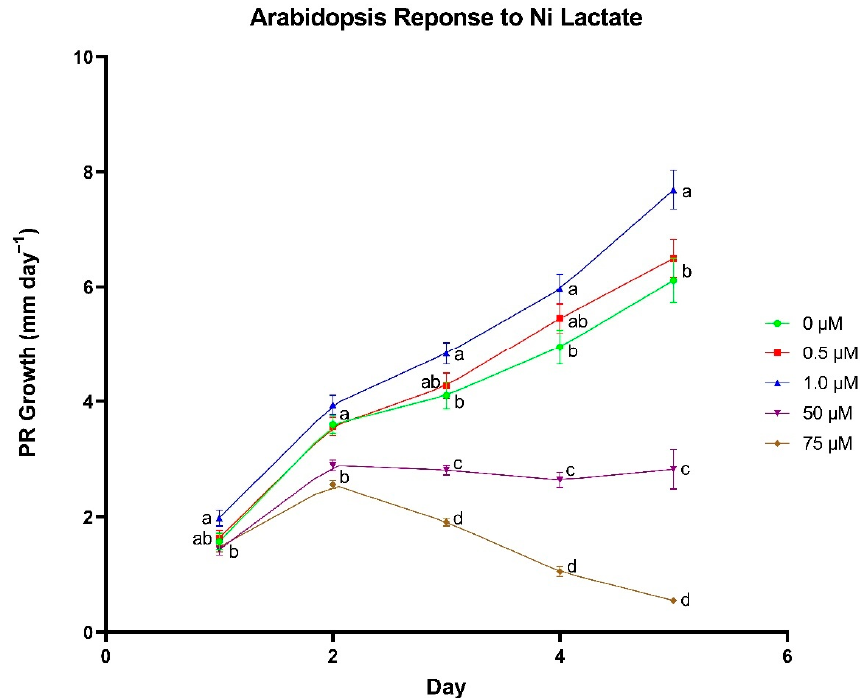
Figure 4. The effect of nickel (Ni) lactate concentration on primary root (PR) growth rate in Arabidopsis thaliana . Differences between means were compared using Tukey’s Honest Significant Difference test, where different letters indicate a statistically significant difference between treatment concentrations in their respective day of growth. Error bars denote means ± SE ( n = 34–95).